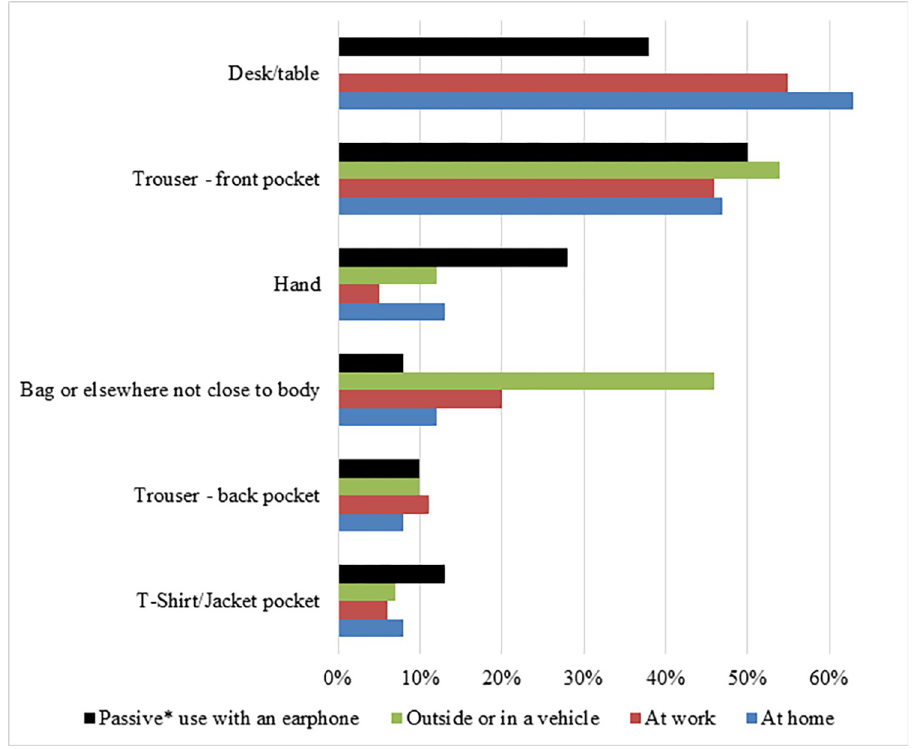
Fig 1. Mobile phone locations when not in use or only passive use ( � passive use: E.g. listening to music/radio/ podcast online).